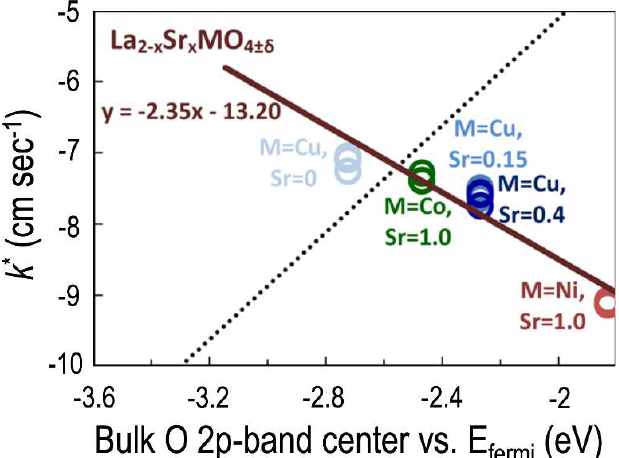
Figure 8. Oxygen surface exchange coefficients ( k * ) of La 2 CuO 4 (light blue), LaSrCoO 4 (green), La 1.85 Sr 0.15 CuO 4 (blue), La 1.6 Sr 0.4 CuO 4 (deep blue), and LaSrNiO 4 (red) films with (001) orientations measured at 550 °C versus the computed DFT bulk O 2p-band centers (relative to the Fermi level, E Fermi ). The gray dashed lines represent the correlation between experimental oxygen surface-exchange coefficients and the computed bulk O 2p-band centers for a series of SOFC perovskites. Reprinted from [126] with permission of The American Chemical Society.